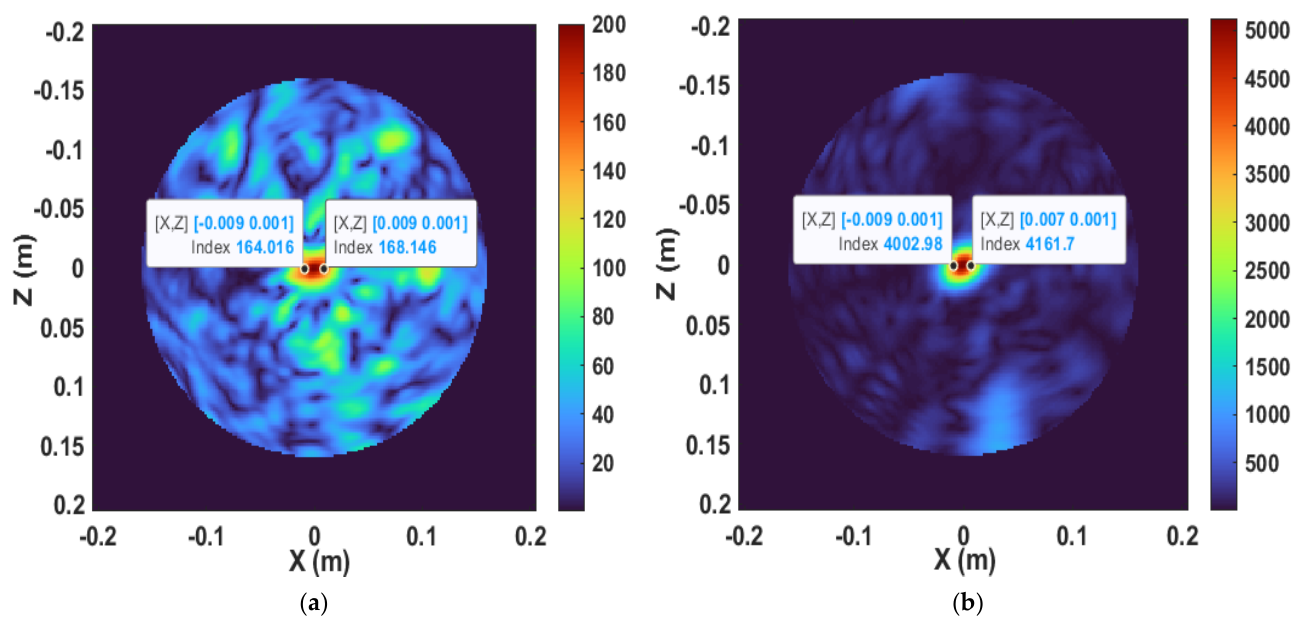
Figure 12. Imaging results of lung phantom with deep-seated 5 mm tumor using two beamformers: ( a ) DAS and ( b ) DMAS. Table 5. MAPE of predicted tumor sizes from reconstructed images by DAS and DMAS.